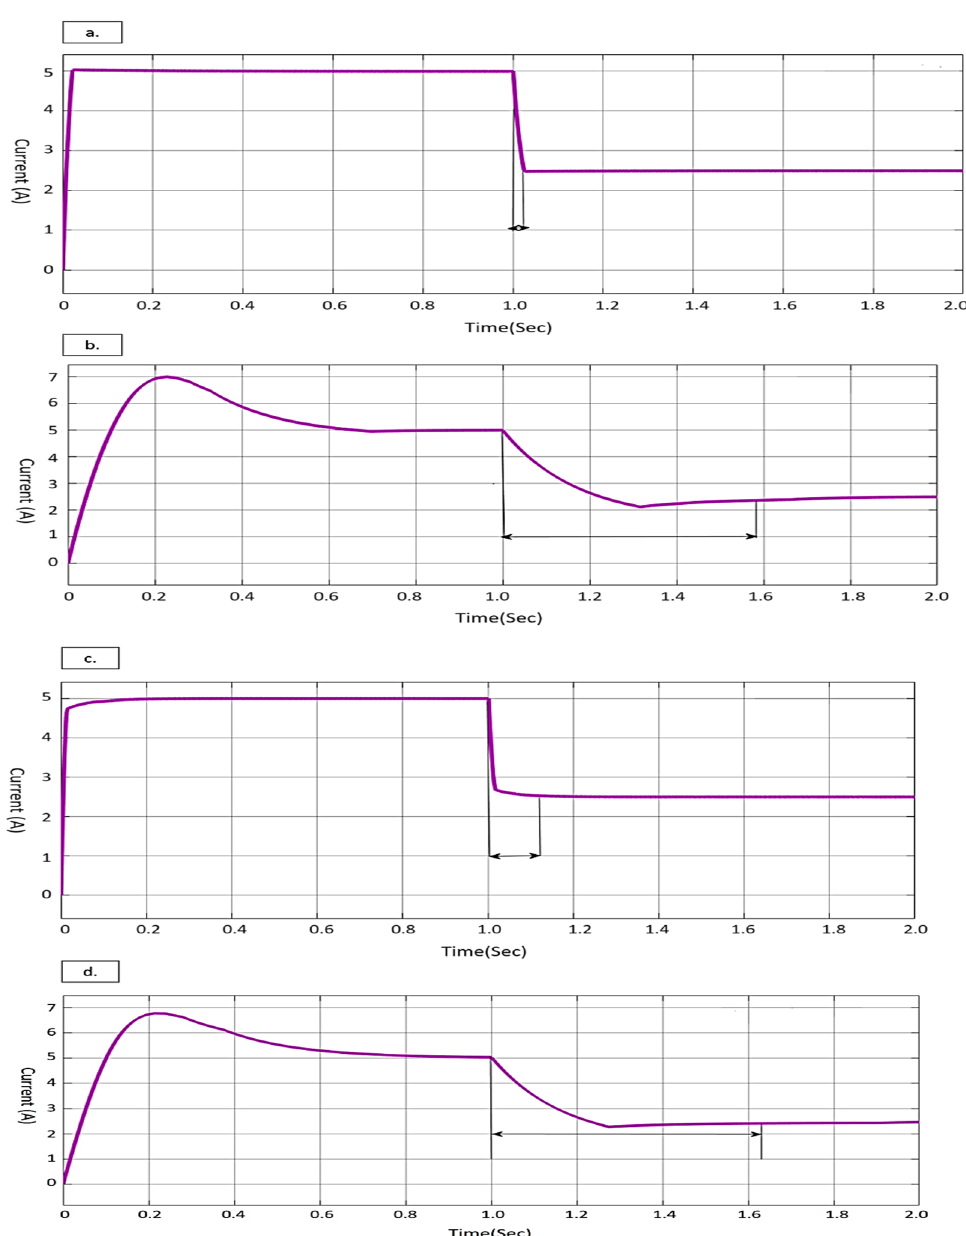
Figure 10. Simulation results when reference current changes from 5 A to 2.5 A after 1 s: ( a ) FCC; ( b ) LCFF; ( c ) MBPS; ( d ) PI.